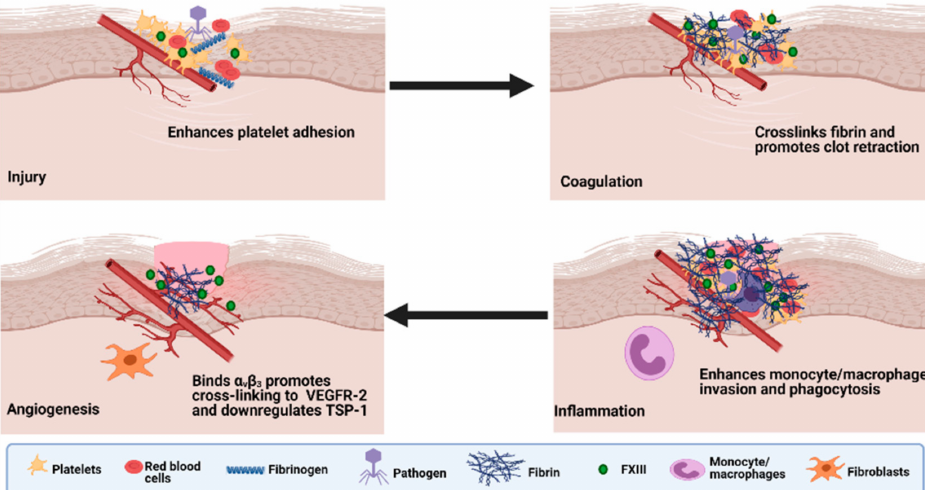
Figure 4. The roles of Factor XIII in wound healing. During injury, FXIII-A enhances platelet ad- hesion to the injured endothelium through an integrin-dependent mechanism. Activated FXIII (FXIIIa) mediates the cross-linking of fibrin and promotes clot retraction. FXIII-A enhances inva- sion of monocytes/macrophages and phagocytosis of cell debris and pathogens. FXIII-A promotes crosslinking of extracellular matrix (ECM) and reduces vascular permeability. FXIIIa binds α v β 3 and promotes cross-linking to vascular endothelial growth factor receptor-2 (VEGFR-2) and downregu- lates thrombospondin-1 (TSP-1). Adapted from the work in